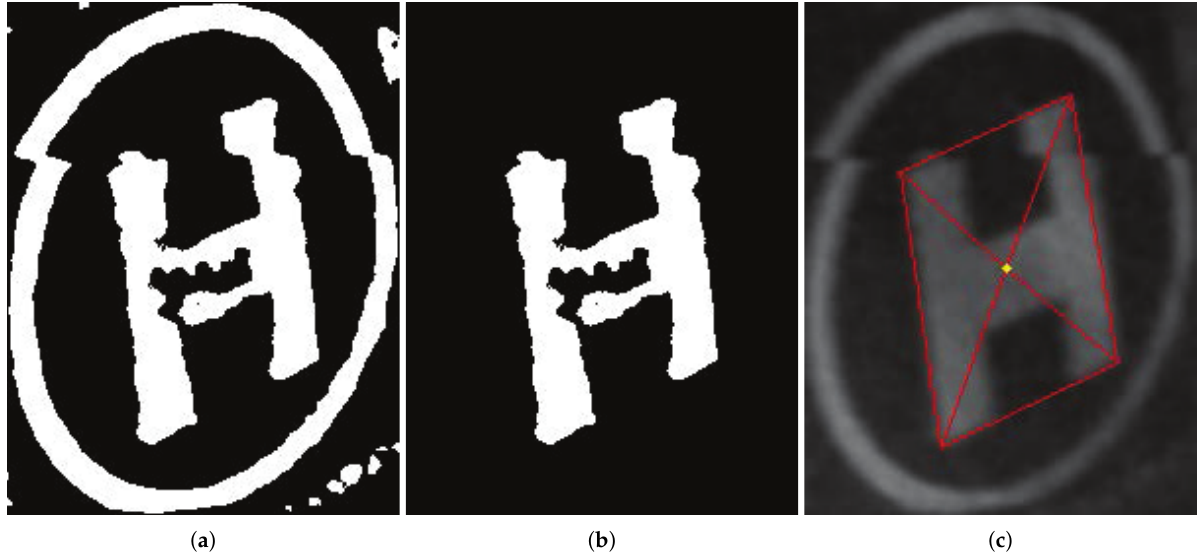
Figure 7. Landing marker keypoint extraction: ( a ) Small outliers are first rejected from the binarized ROI image. ( b ) The circular pattern is removed, and the “H” pattern is reserved. ( c ) The vertices and center are obtained by fitting a bound- ing